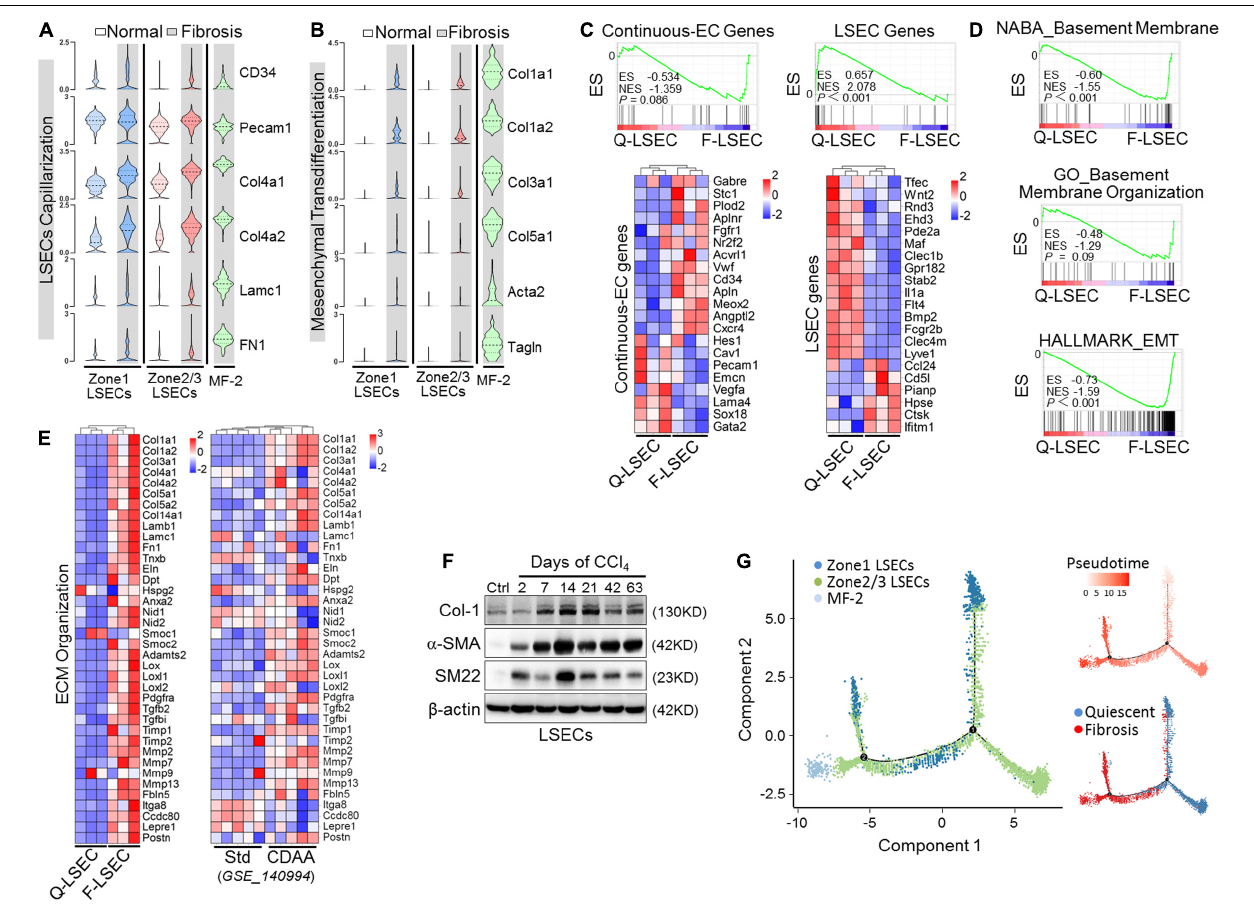
FIGURE 5 | Capillarized LSECs undergo EndMT during liver fibrogenesis. (A,B) The expressions of capillarization markers (A) and mesenchymal markers (B) in different EC subpopulations between normal and fibrosis are shown by violin plots. (C–E) LSECs were isolated from mice injected with CCl 4 or oil for 6 weeks and subjected to RNA-seq ( n = 3). Continuous EC- and LSEC-associated genes were compared between the two types of LSECs with GSEA and heat maps (C). Transcriptomes were further analyzed by GSEA for vascular basement membrane formation/organization and epithelial mesenchymal transition (D). Genes involved in ECM organization were compared between normal and fibrotic LSECs (left, Q-LSEC vs. F-LSEC; right, Std-LSEC vs. CDAA-LSEC) with a heat map (E). (F) LSECs were isolated from wild-type mice treated with oil or CCl 4 for the indicated days, and the expression of mesenchymal markers (Col-1, α -SMA, and SM22) was determined by Western blotting. (G) Pseudotemporal cell ordering of MF-2 and LSEC subpopulations along differentiation trajectories by using Monocle. Pseudotime is depicted from light to dark red. Q-LSEC, quiescent LSEC; F-LSEC, fibrotic LSEC; Std, standard; CDAA, choline-deficient, l-amino acid-defined; GSEA, Gene Set Enrichment